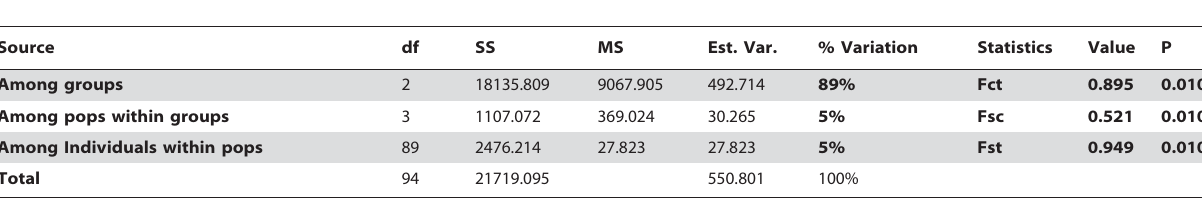
Table 1. Summary results of AMOVA analyses within and among populations of 95 accessions of the domesticated and wild